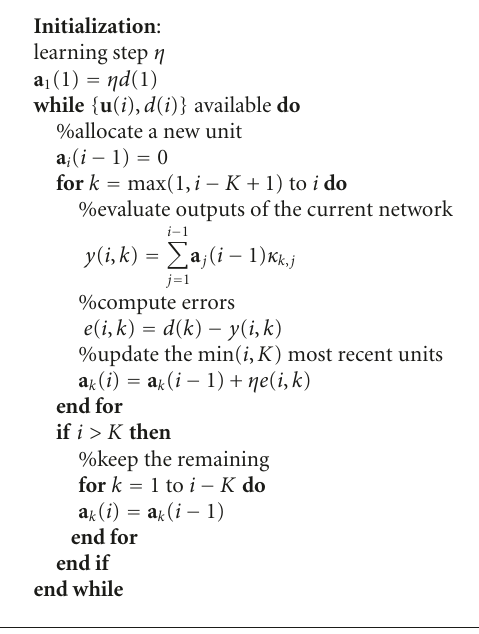
Algorithm 1: Kernel a ffi ne projection algorithm